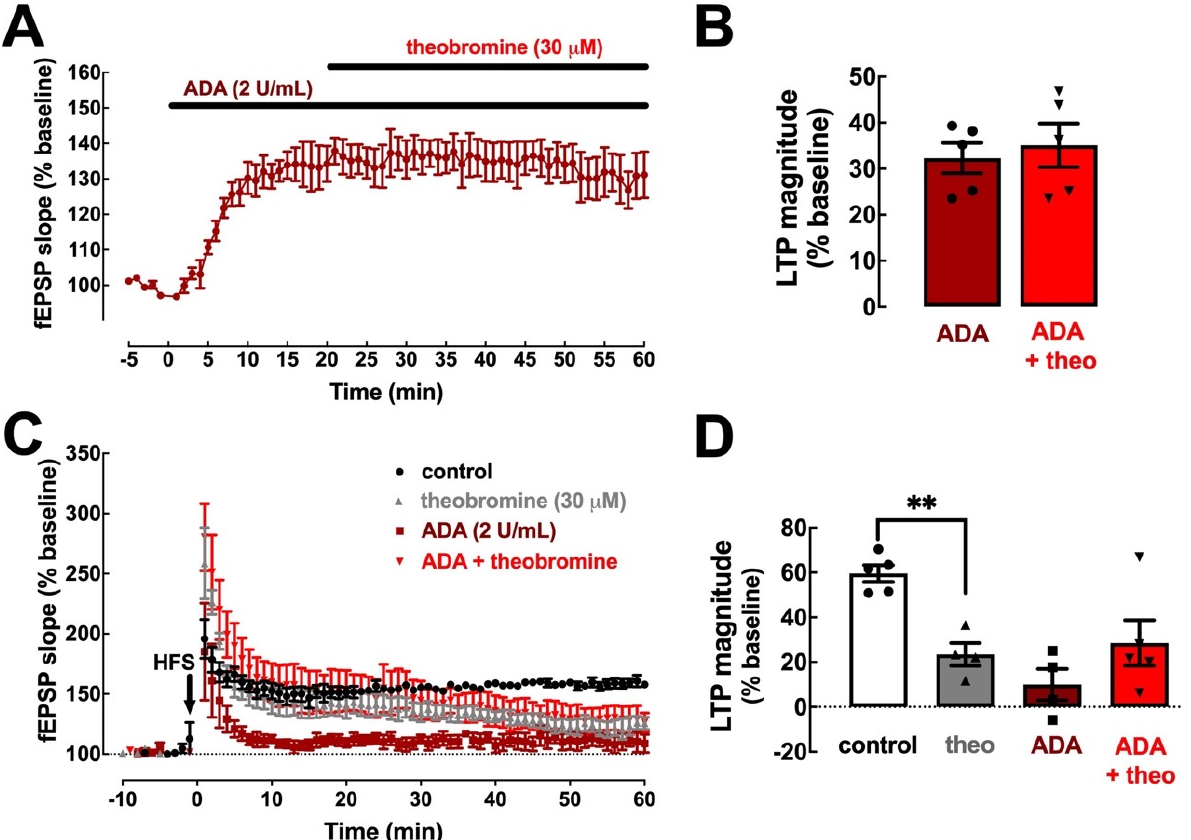
Figure 2. Clearance of endogenous extracellular adenosine abolishes the effects of theobromine on synaptic transmission and plasticity. Adenosine deaminase (ADA, 2 U/mL) enhanced hippocampal basal synaptic transmission ( A , B ) and abrogates the effects of theobromine (30 µ M). ADA (2 U/mL) also decreased the magnitude of long-term potentiation ( C , D ) induced by a high-frequency stimu- lation train (HFS: one train of 100 pulses of 1 Hz for 1 s) in Schaffer fiber-CA1 pyramid synapses of mouse hippocampal slices and abrogates the effects of theobromine (theo, 30 µ M). This shows that these measured effects of theobromine are strictly dependent on the presence of endogenous extracellular adenosine. Data are mean ± S.E.M. of 5 ( A , B ) and 4–5 ( C , D ) experiments. The asterisks denote significant differences: ** p < 0.01 vs. control, two-way ANOVA with Tukey’s post hoc test.